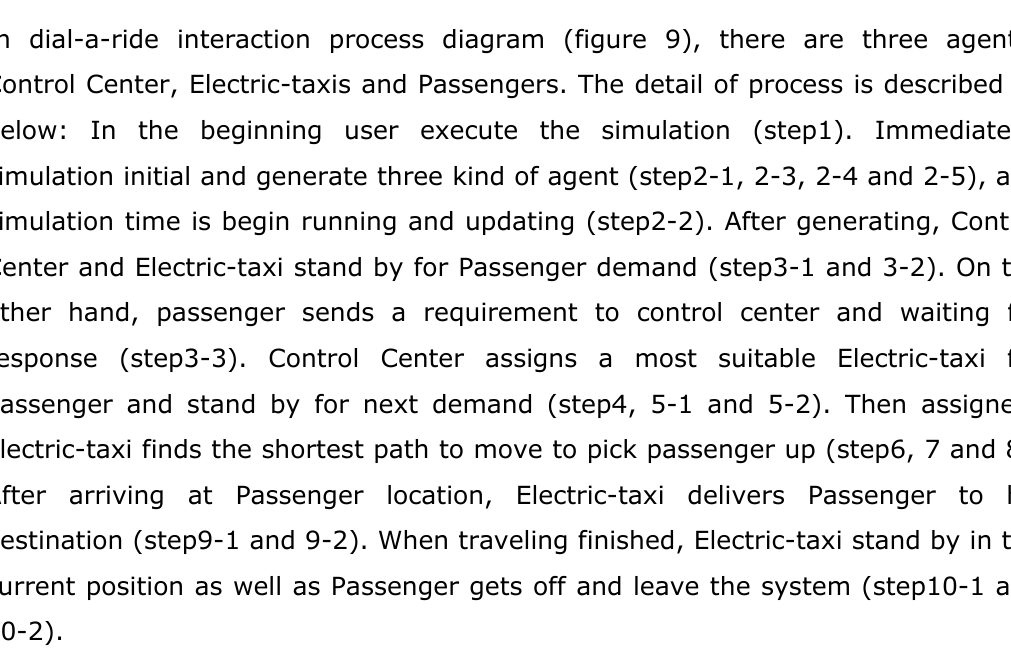
Figure 9. “ Dial-a-ride interaction